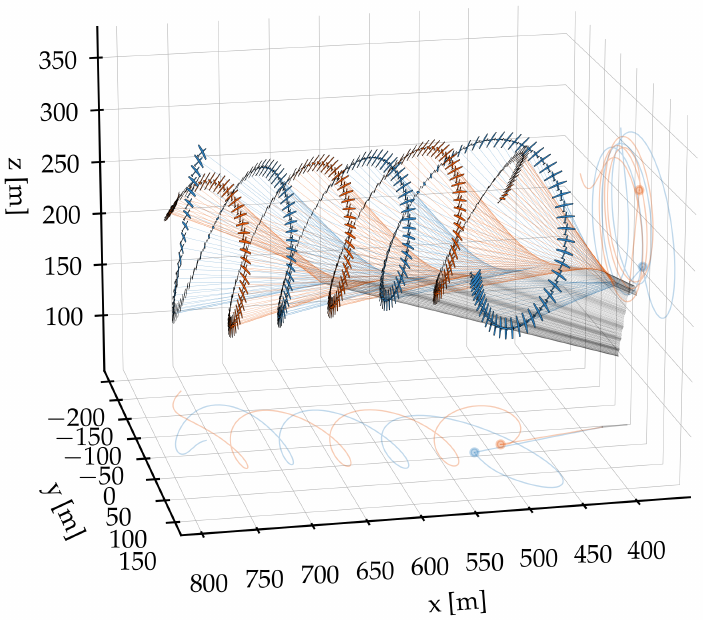
Figure 7. Optimal dual-aircraft flight trajectories for u ref = 18 m the aircraft are depicted at a scale 3.3:1. Aircraft k = 2 is plotted in blue, aircraft k = 3 in orange.